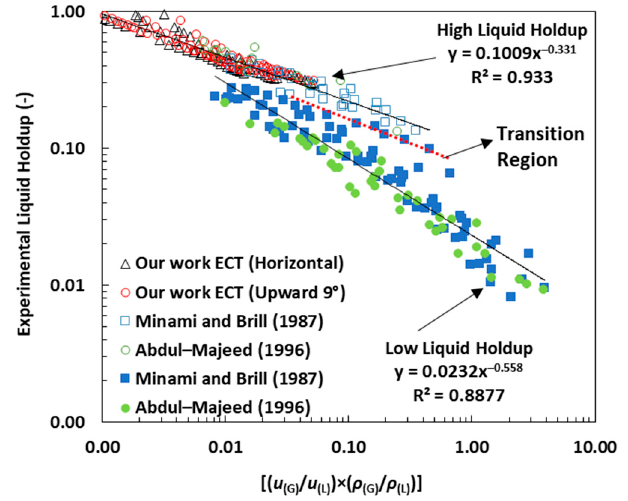
Figure 5. The experimental ε (L) expressed as a function of the dimensionless quantities in Equation (10): logarithmic comparison of ε (L) (i.e., 310 data points) obtained from this work, [51,53].